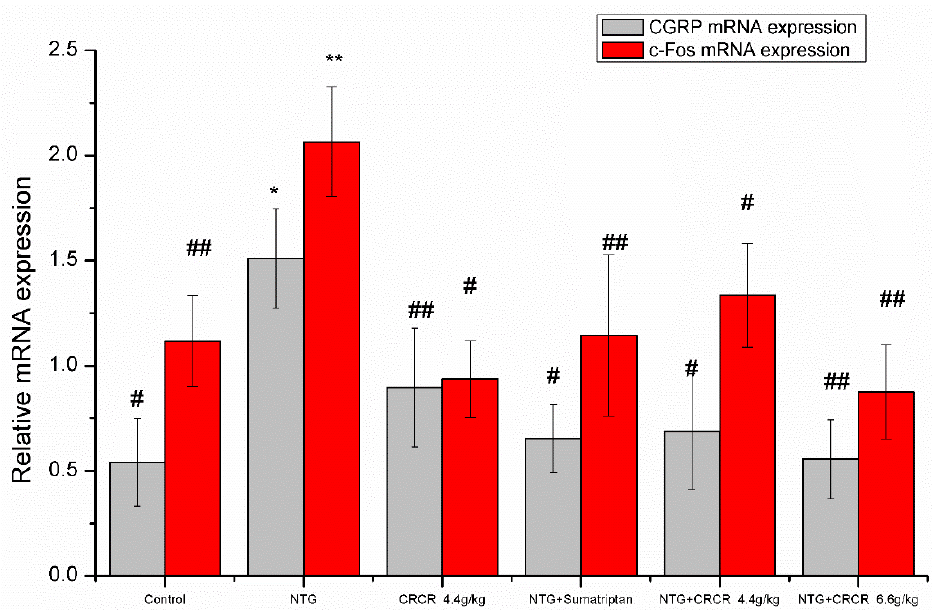
Figure 3. Effects of CRCR on CGRP mRNA and c-fos mRNA expression in the brainstem detected by qRT-PCR. Data are expressed as mean±S.E. * p < 0.05, ** p < 0.01 vs control group, # p < 0.05, ## p < 0.01 vs NTG group.